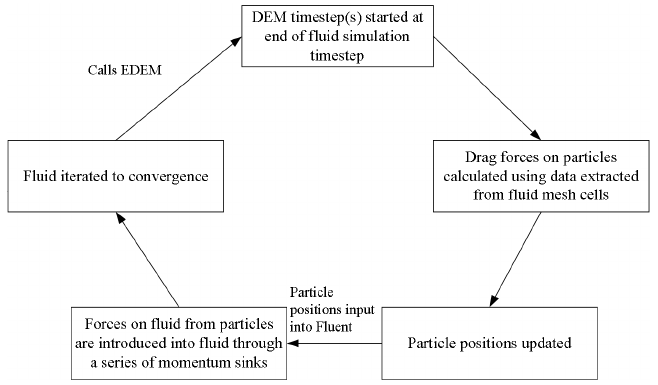
Figure 3. Flow chart of EDEM-FLUENT coupling processes and information exchange between two solvers.